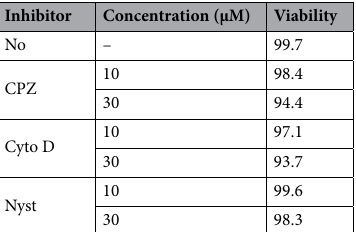
Table 1. Viability of S2 cells incubated with chlorpromazine (CPZ), cytochalasin D (Cyto D) and nystatin (Nyst) observed one day post